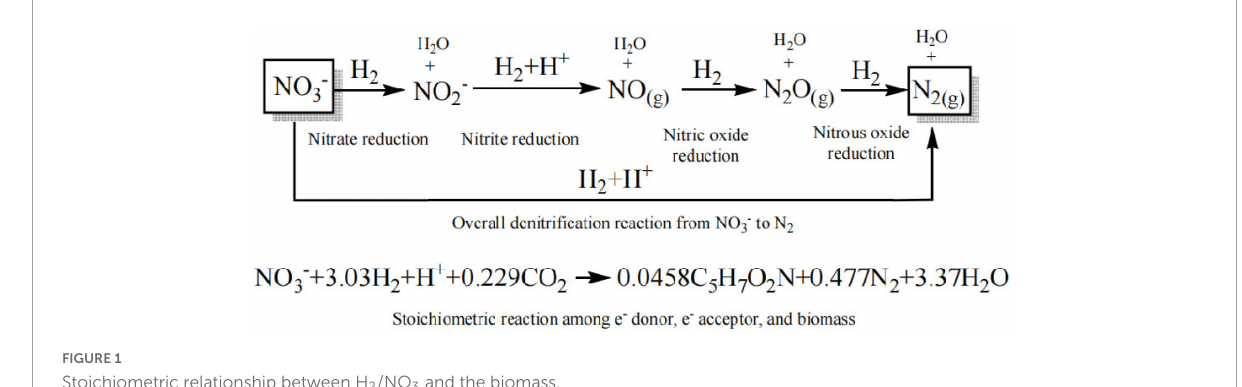
FIGURE1 Stoichiometric relationship between H 2 /NO 3 and the biomass.